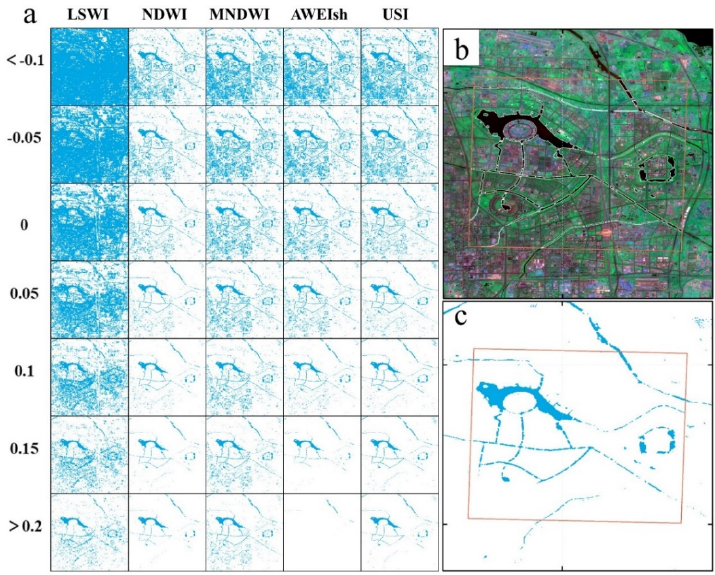
Figure 6. Experimental area A for comparison of water body extraction methods: ( a ) extraction results using different water body indexes with different thresholds, ( b ) real water profile, and ( c ) results obtained using the automatic urban surface water mapping (AUSWM) method.